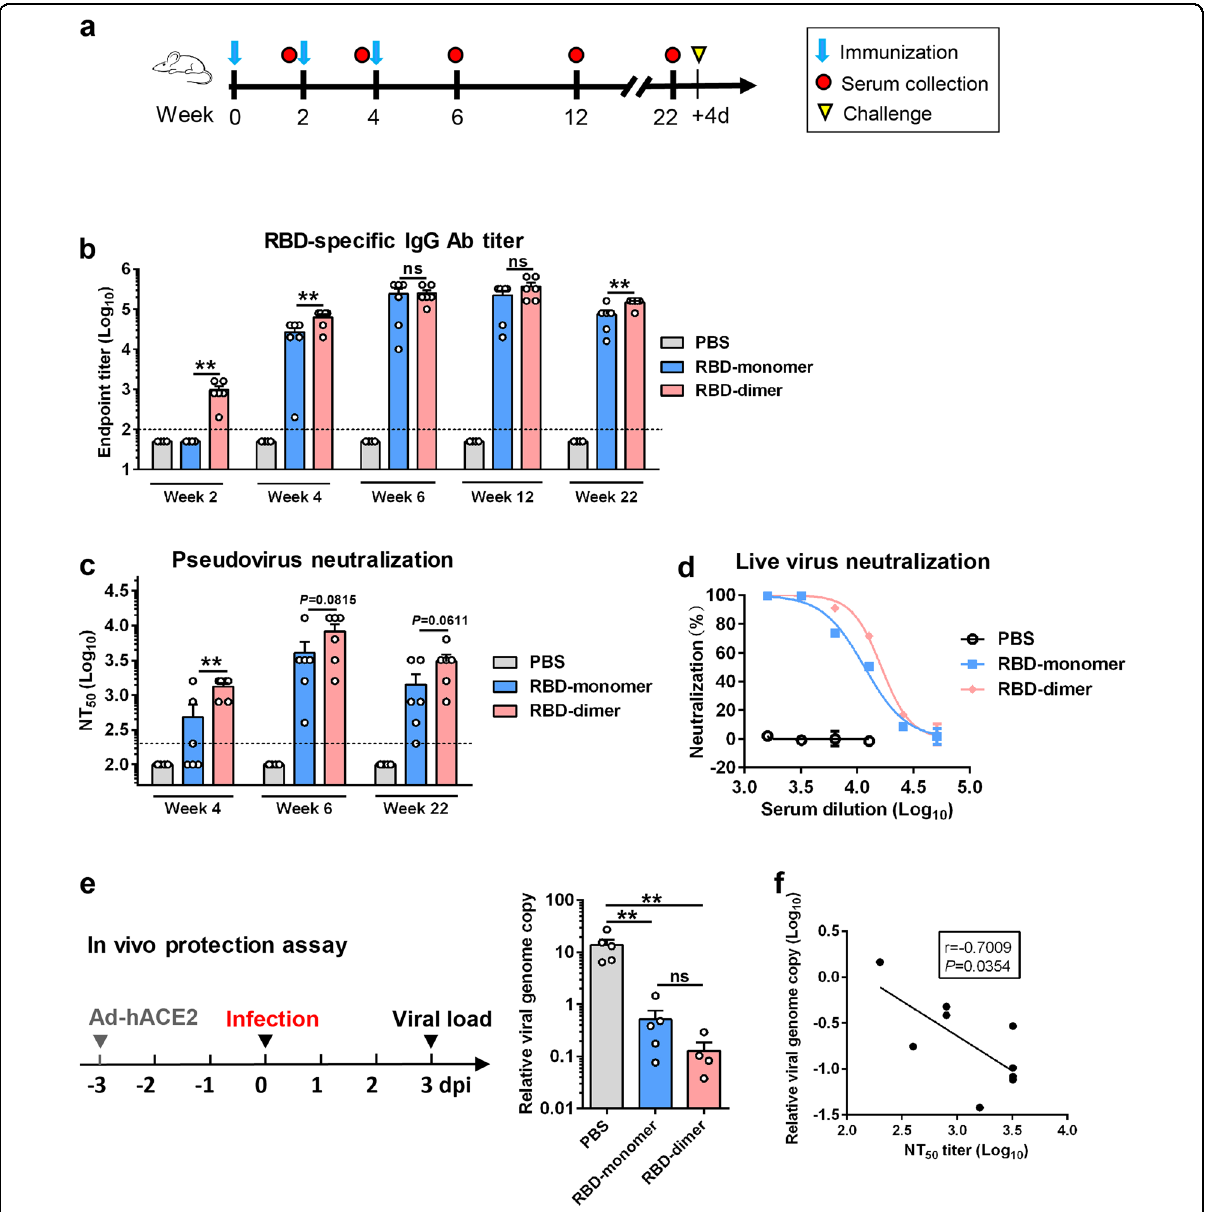
Fig. 6 Direct comparison of immunogenicity and protective ef fi cacy was made between RBD-monomer and -dimer proteins. a Schedule of mouse immunization and challenge experiments. Three groups of BALB/c mice were immunized with alum-formulated RBD-monomer (10 μ g/dose), RBD-dimer protein (10 μ g/dose), or PBS at weeks 0, 2, and 4. Serum samples were harvested at weeks 2, 4, 6, 12, and 22. All mice were challenged with live SARS-CoV-2 at 4 days after the last blood draw. b The antisera were analyzed for RBD-binding antibody titers by ELISA. PBS immune sera did not exhibit any binding activity at the lowest dilution (1:100; dashed line) and was denoted as a titer of 50. c Neutralizing antibody titers of the antisera against SARS-CoV-2 pseudovirus. Anti-PBS sera did not confer any neutralization at the lowest dilution (1:200; dashed line) and was denoted as a NT 50 value of 100. Each symbol represents one mouse. d Neutralization activity of the pooled week-6 immune sera against live SARS-CoV-2. e In vivo challenge assay. Immediately after the last blood draw at week 22 (see panel a ), the vaccinated mice were transduced with Ad5-hACE2 and 3 days later challenged with live SARS-CoV-2. Mouse lungs were collected 3 days post infection and analyze for viral loads by qRT-PCR. Left panel: study outline. Right panel: qPCR results are shown as viral RNA levels relative to GAPDH, using 2 − Δ Ct method. Each symbol represents one mouse. f The negative correlation between pulmonary viral load and serum neutralizing antibody titers. In panels b – e , data are means ± SEM of triplicate wells. In panels b , c , and e , P values were analyzed with unpaired t -test and indicated as follows: ns, not signi fi cant; ** P <